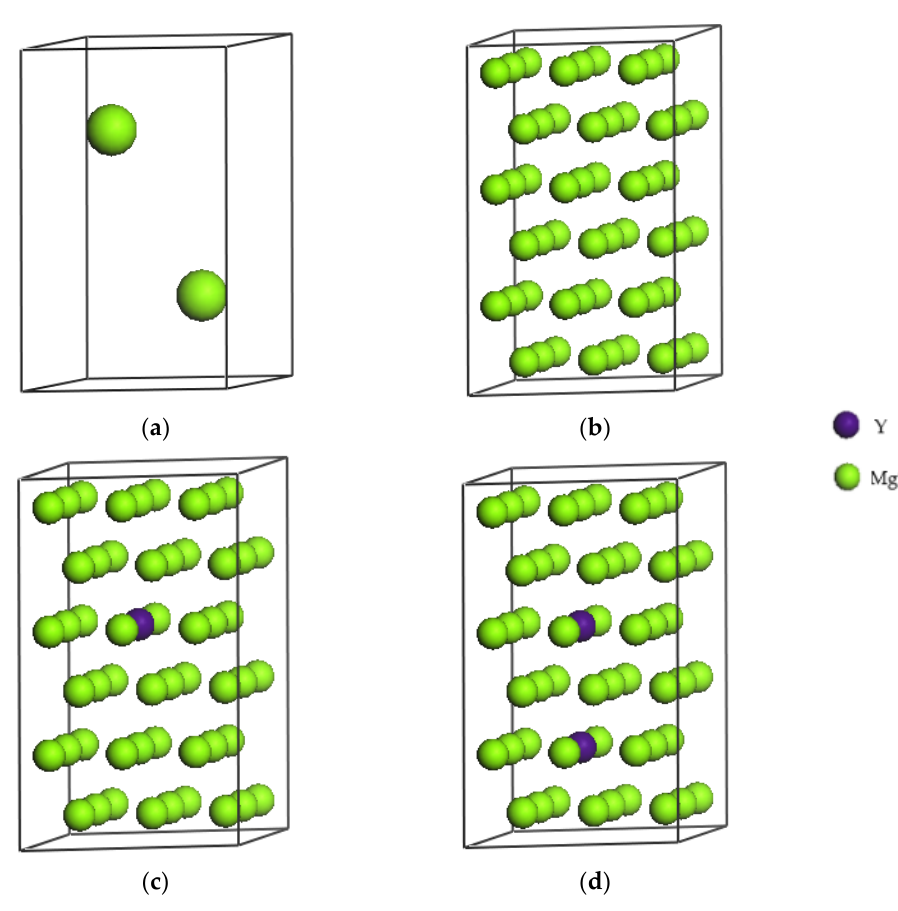
Figure 1. Crystal structures of Mg ( a ), Mg 54 ( b ), Mg 53 Y 1 ( c ) and Mg 52 Y 2 ( d ).